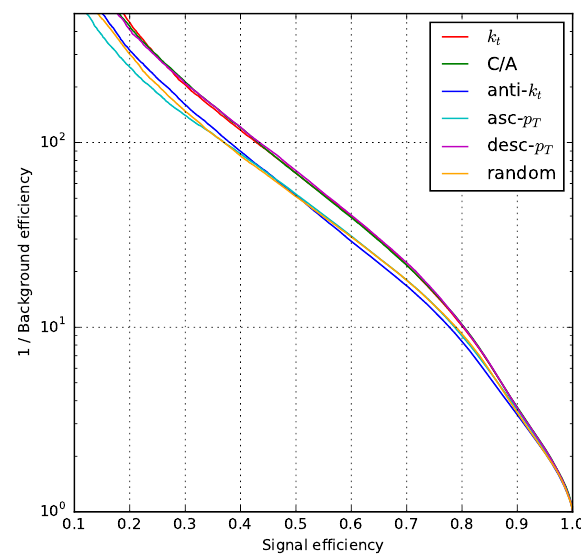
Figure 4 . Jet classi(cid:12)cation performance of the RNN classi(cid:12)er based on various network topologies for the embedding ( particles scenario). This plot shows that topology is signi(cid:12)cant, as supported by the fact that results for k t , C/A and desc- p T topologies improve over results for anti- k t , asc- p T and random binary trees. Best results are achieved for C/A and desc- p T topologies, depending on the metric